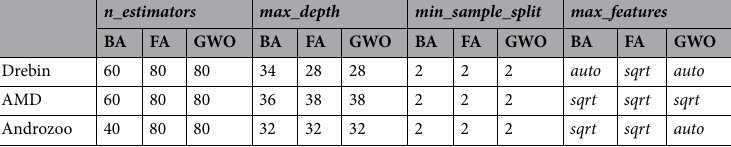
Table 8. Hyper-parameters for RF proposed by NIAs.